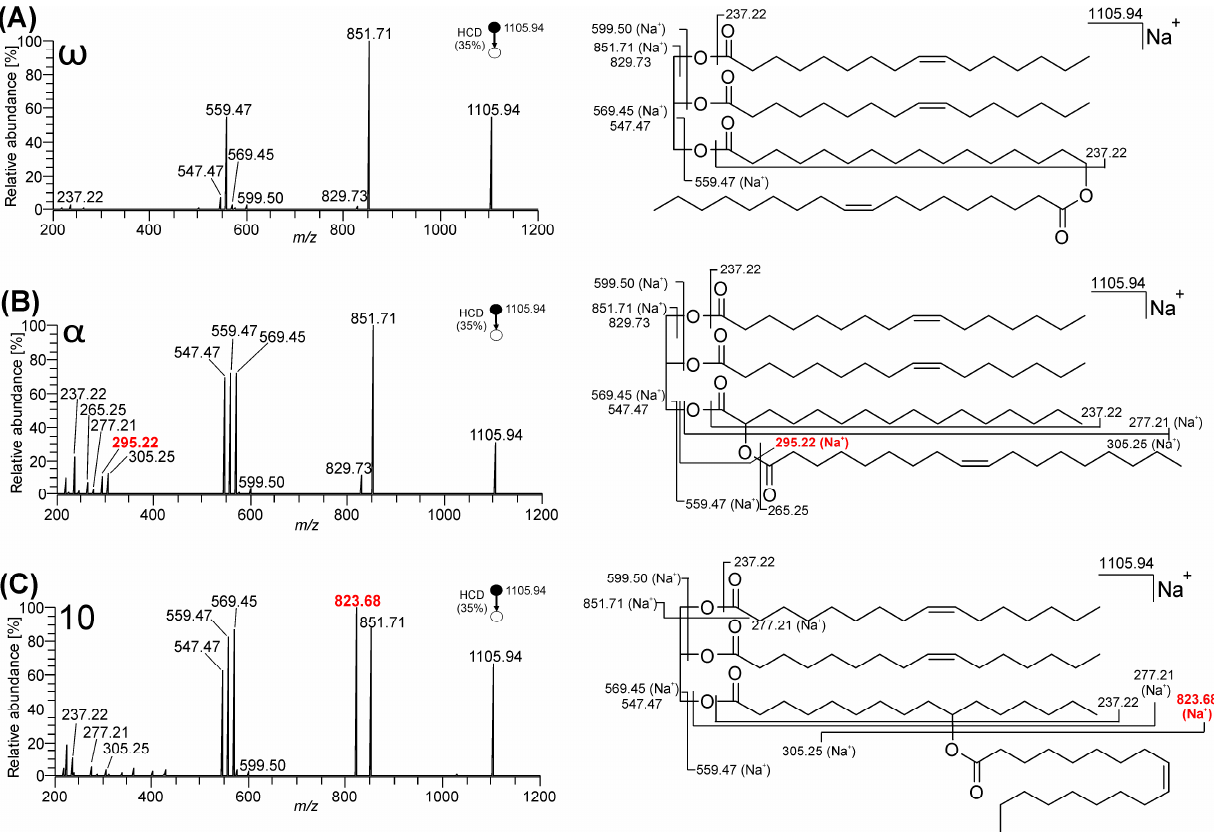
Figure 5. MS 2 HCD spectra of TG ‐ EST [M + Na] + (NCE 35%): ( A ) TG ‐ EST 1 — ω‐ isomer; ( B ) TG ‐ EST 2 — α‐ isomer; ( C ) TG ‐ EST 3 — ω‐ isomer. Diagnostic fragment ions for the various positional isomers are highlighted in red.